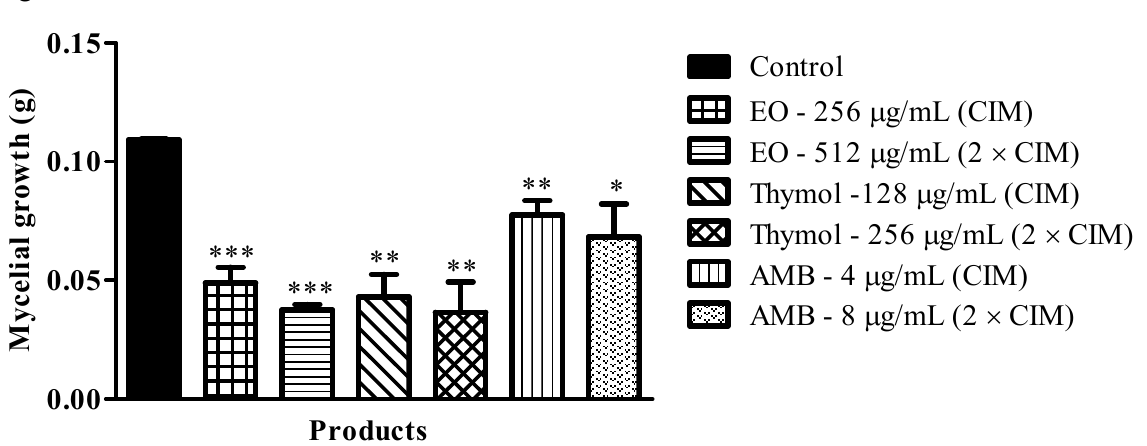
Figure 1. Effect of T. vulgaris essential oil, thymol and amphotericin B on mycelial growth of